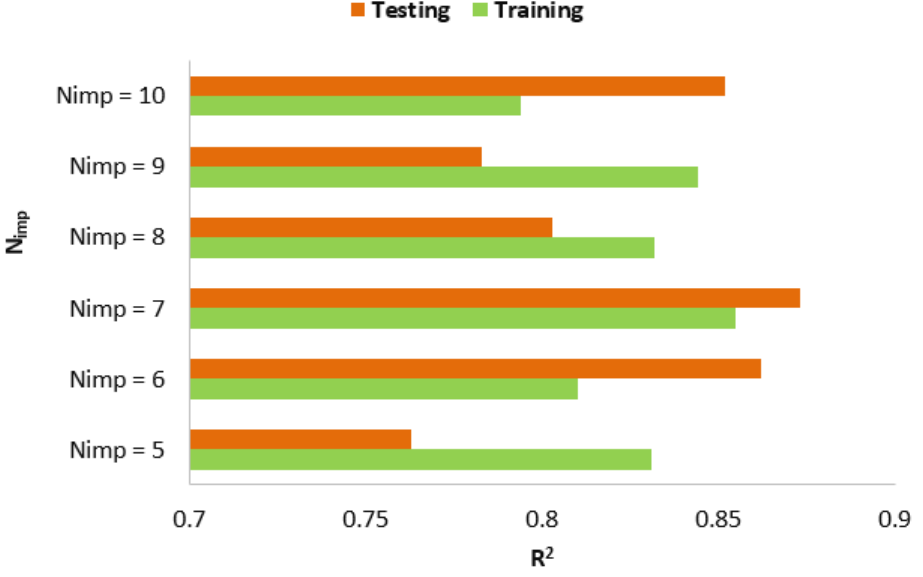
Figure 13. Results of N imp in ICA-ANN models.